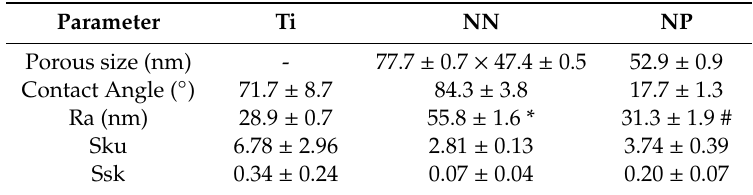
Table 1. Physical characterization of the di ff erent titanium surfaces. Values represent the mean ± SEM ( n = 5). Ra = average roughness; Ssk = surface skewness; Sku = surface kurtosis. Results were statistically compared by analysis of variance (ANOVA) and Student’s t -test as post hoc: * p < 0.05 versus Ti; # p < 0.05 versus nanonet (NN) for Ra and Ssk and by Kruskall Wallis for Sku. NP, nanopore.